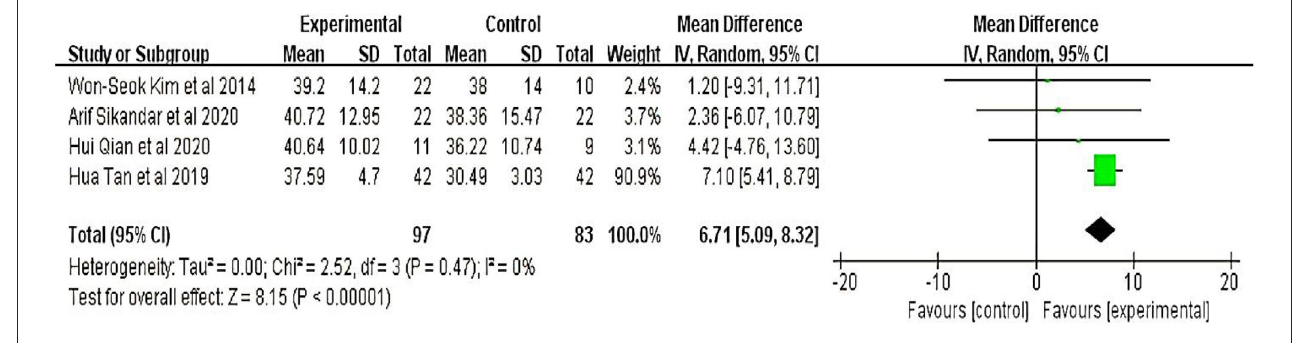
FIGURE3 Berg Balance Scale (BBS).